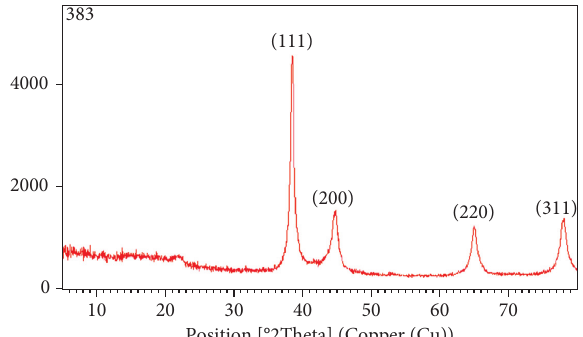
Figure 5: XRD spectrum showing peaks corresponding to the diffraction from (111), (200), (220), and (311) planes of fcc lattice of Ok Au NPs.